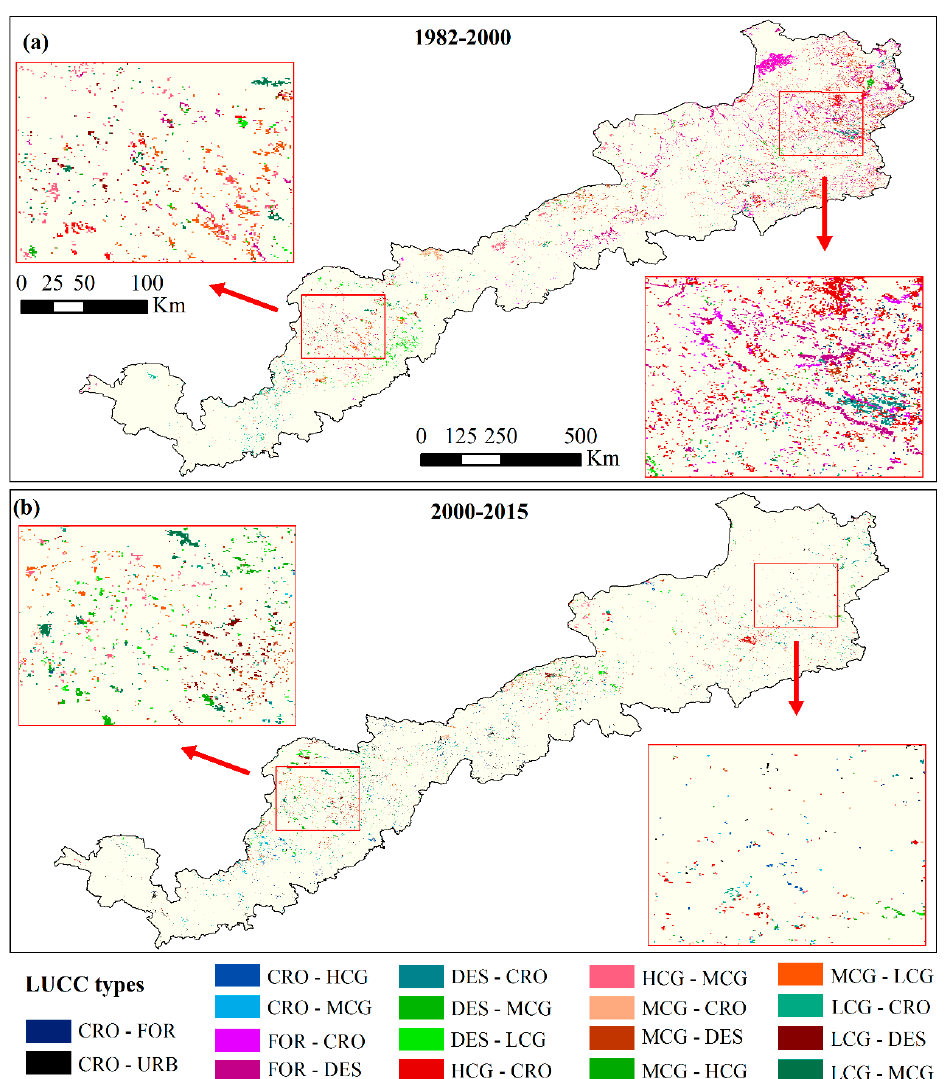
Figure 3. Land use and land cover (LUCC) types conversion between ( a ) 1982 and 2000 and ( b ) 2000 and 2015. CCR is croplands, FRO is forests, URB is urban construction lands, DES is deserts, HCG is high-coverage grasslands, MCG is medium-coverage grasslands, and LCG is low-coverage